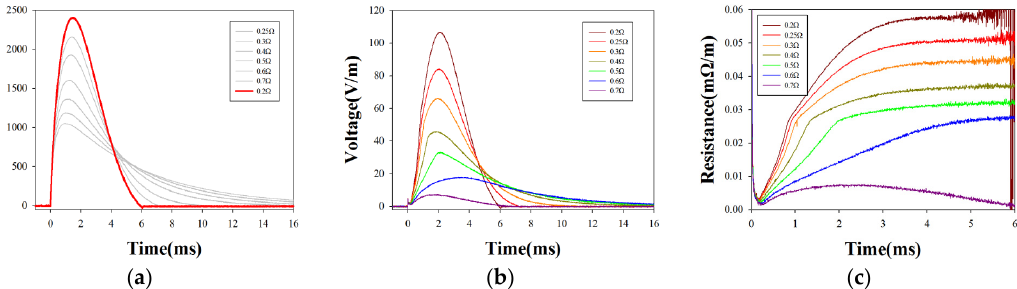
Figure 3. Fixed impulse test platform L = 0.2 mH while varying R: ( a ) impulse current waveform; ( b ) impulse voltage waveform; ( c ) resistance response waveform.